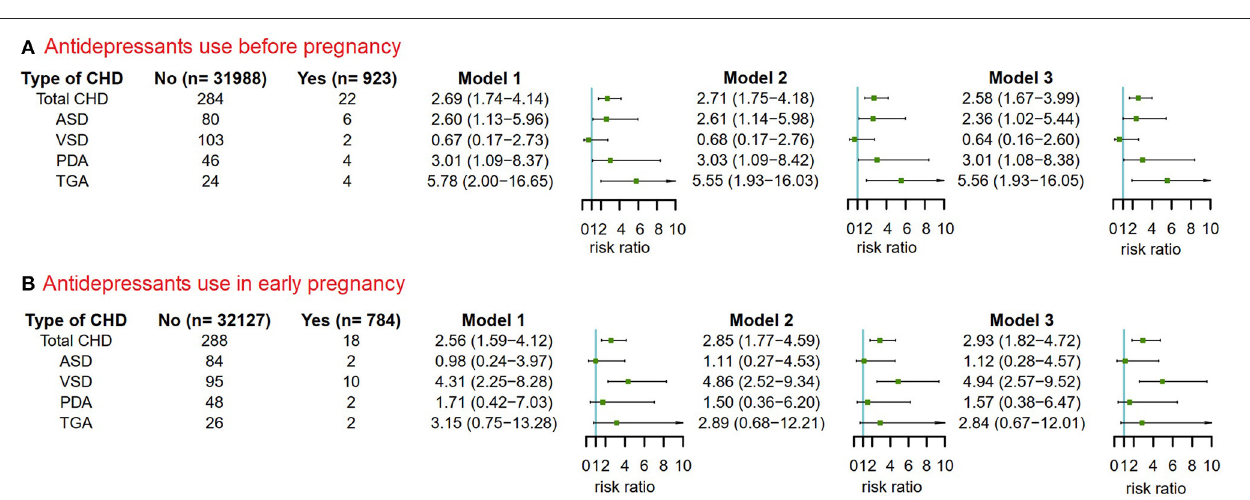
FIGURE 5 | The risks of CHD in offspring of pregnant women exposured to antidepressant in 3 months before pregnancy and in early pregnancy after excluding pregnant women whose children had non-cardiac defects. Model 1 was a crude model without any variable adjusted. Model 2 adjusted for maternal age, ethnicity, residence location, education level, history of gestational diabetes mellitus and history of gestational hypertension. Model 3 adjusted for maternal age, ethnicity, residence location, education level, history of gestational diabetes mellitus, history of gestational hypertension, smoking before pregnancy and alcohol drinking before pregnancy. CHD, congenital heart disease. (A) Antidepressants use before pregnancy. (B) Antidepressants use in early